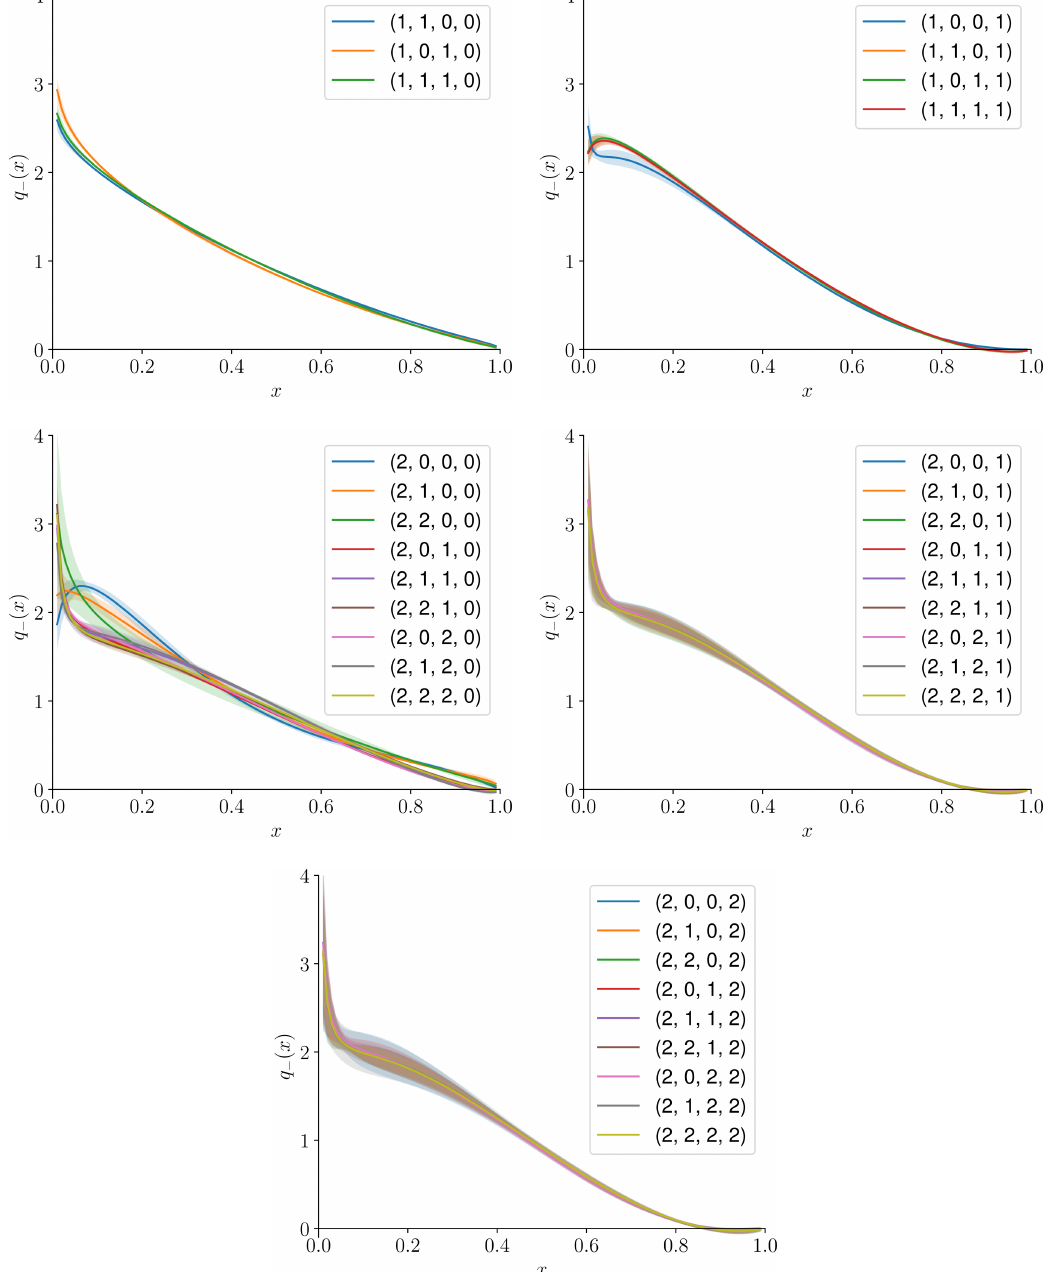
Figure 14 . The PDF results from fitting the real component to the models. The numbers in the legend correspond to ( N ± , N